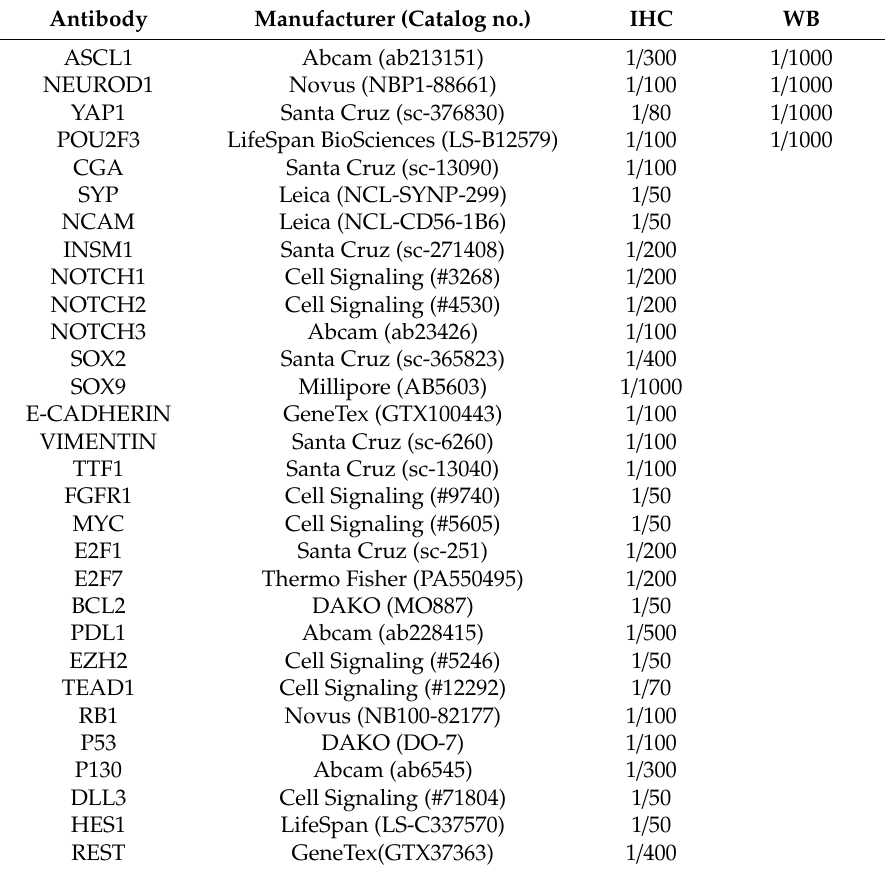
Table 1. List and dilution of antibodies for IHC and the WB